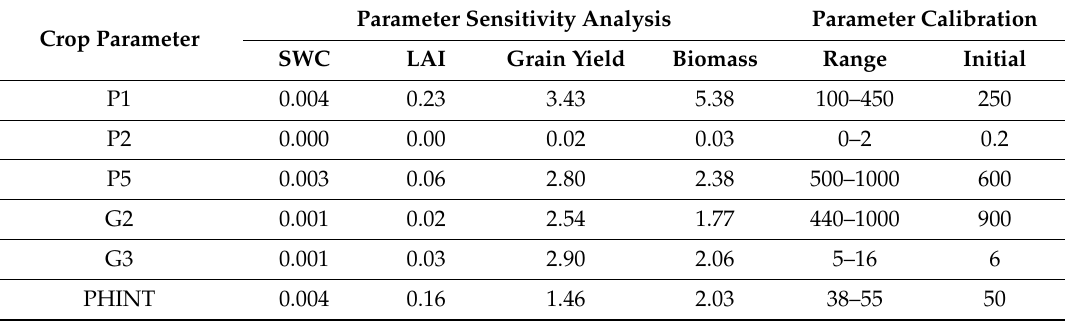
Table 1. Sensitivity analysis of model outputs to these crop cultivar parameters, and their initial values and ranges as reported in the literature for the CERES (Crop Environment Resource Synthesis)-maize model in RZWQM2 (Root Zone Water Quality Model 2)